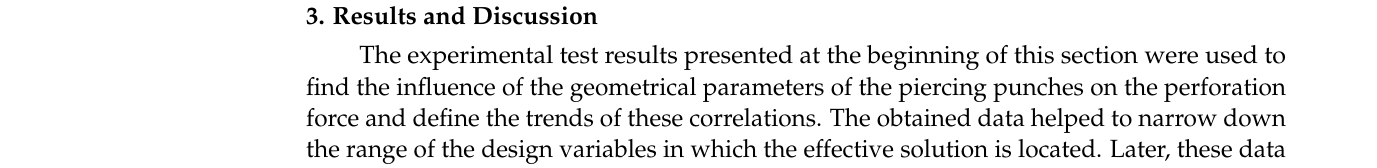
Table 2. Simulation parameters used in FEM modelling of the punching.